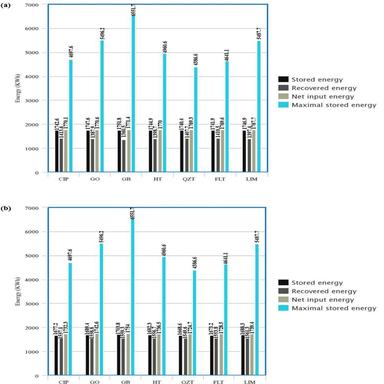
6. Energy comparison when different types of rocks are used as filler materials in the packed bed storage system. (a): Single cycle; (b): Ten consecutive cycles.